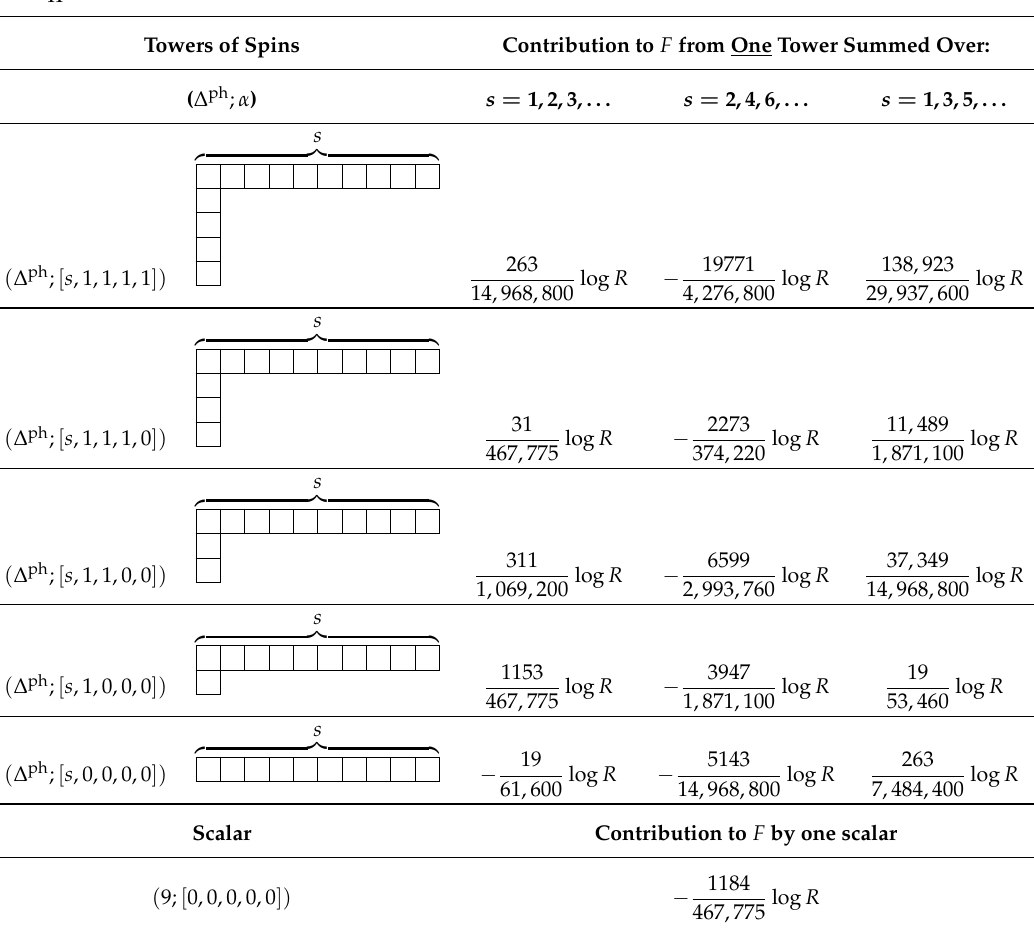
Table A6. Results for Type B theory in AdS 11